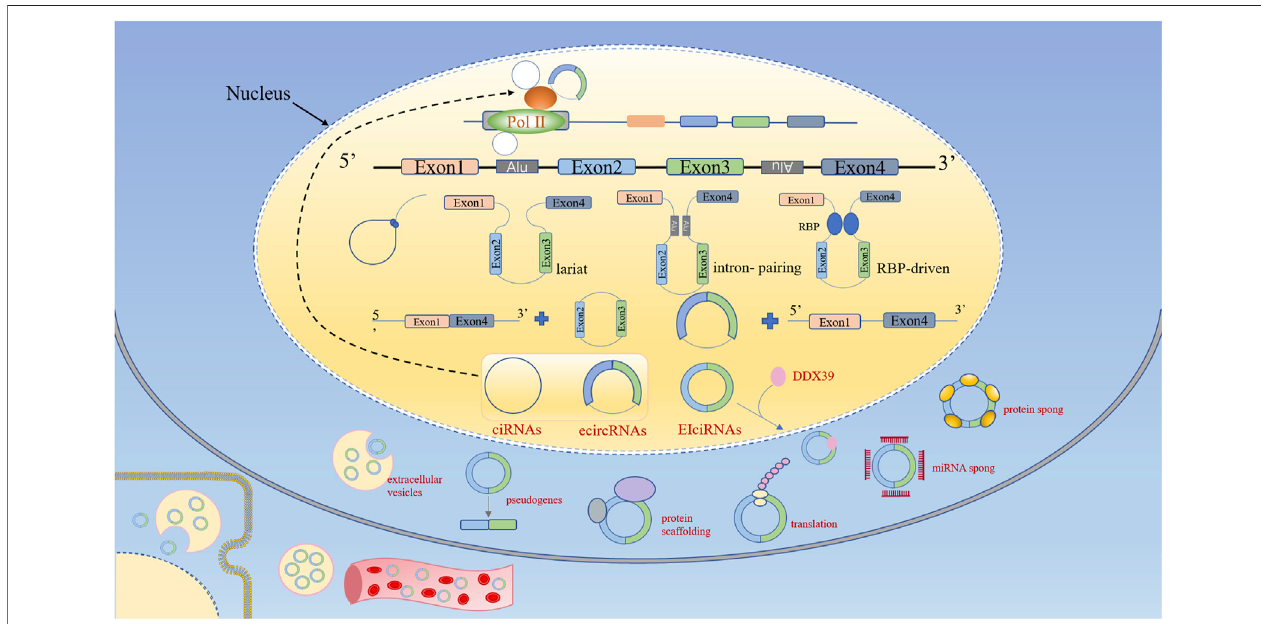
FIGURE 1 | Biogenesis and functions of circular RNAs (circRNAs). According to their composition, circRNAs can be classi fi ed into four categories: ecircRNAs, ciRNAs, EIciRNAs,and tricRNAs. CircRNAbiogenesiscompeteswithlinearpre-mRNAsplicing.CircRNAs enhancethetranscription andsplicingoftheirparentalgenes by interacting with RNA pol II or U1 small nuclear snRNP. CircRNAs bind to RBPs to regulate their biological activity. CircRNAs function as miRNA sponges. CircRNAs can be translated into proteins. CircRNAs function as protein scaffolds. CircRNAs-derived pseudogenes. CircRNAs are eliminated by extracellular vesicles into extracellular space, and can be absorbed by other cells or could enter the